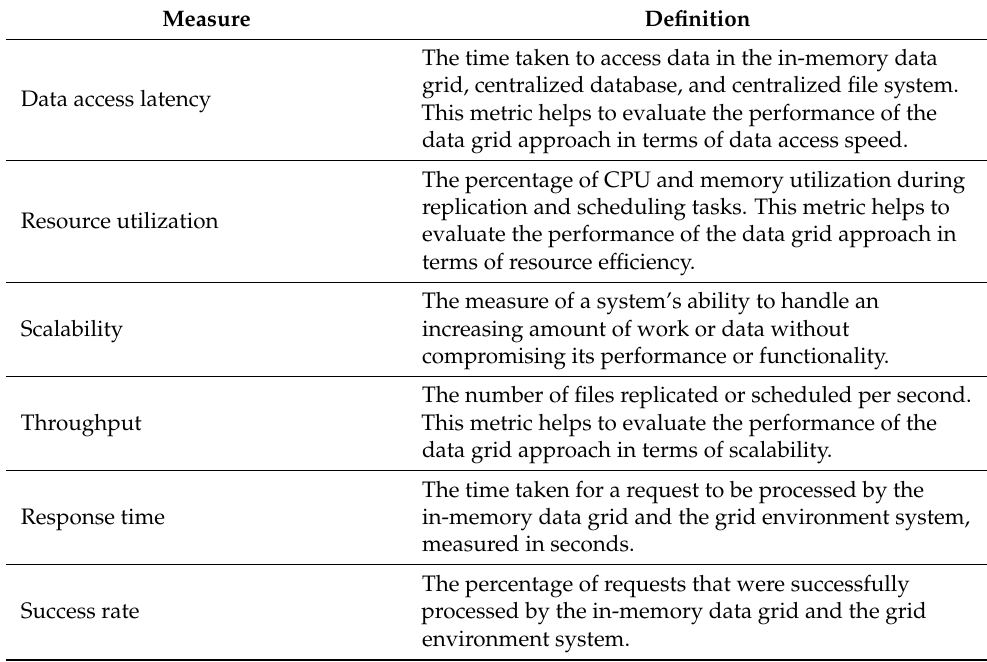
Table 1. Performance measures’